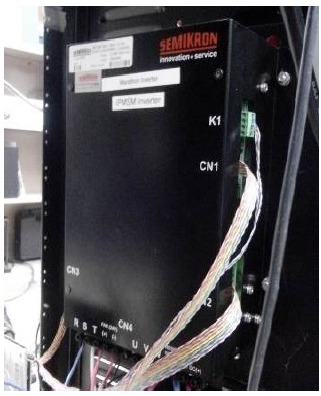
Figure 12. A Semikron power converter.